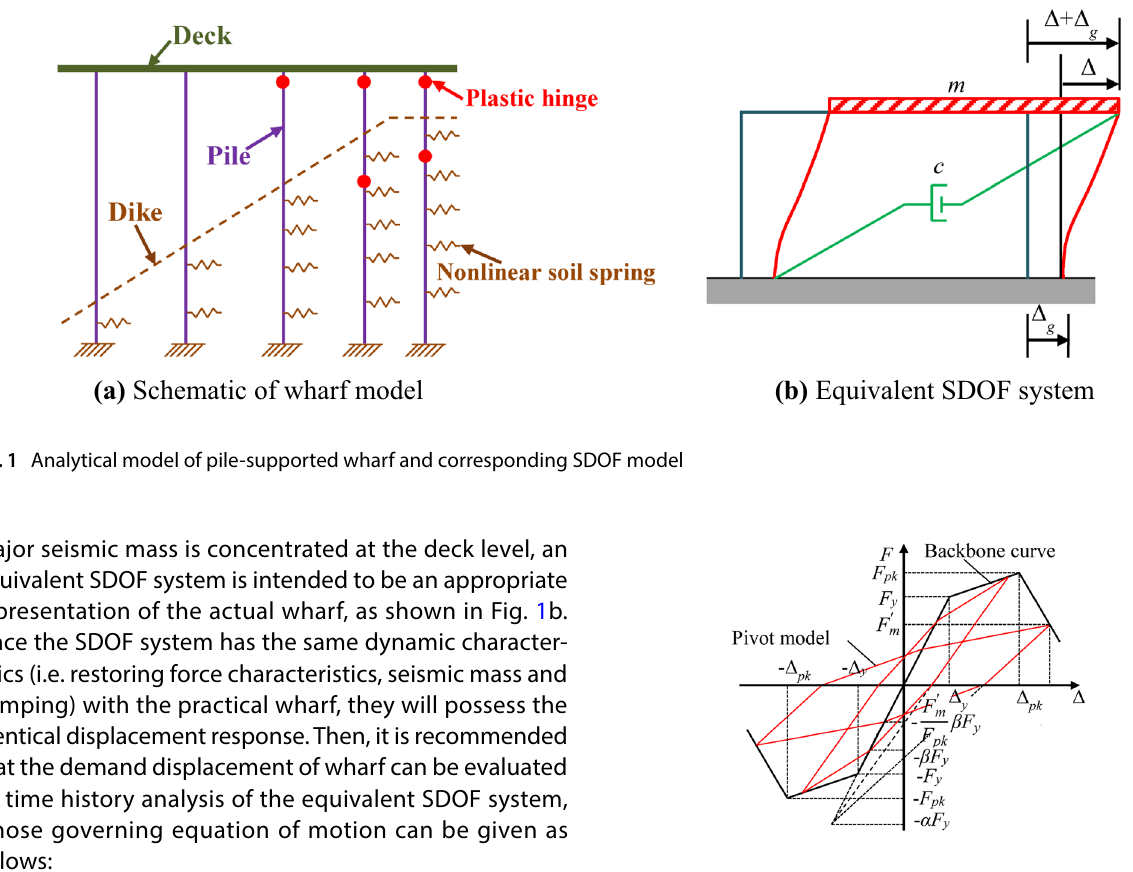
Fig. 2 Backbone curve and Pivot hysteresis rule